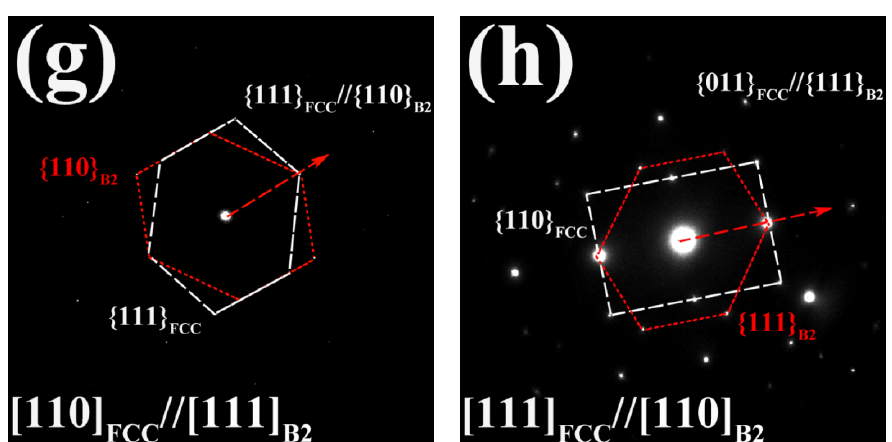
Figure 5. TEM images and corresponding SADP of B2 phase in 90% rolled and annealed samples: ( a ) AR500 sample; ( b ) AR540 sample; ( c ) AR590 sample; ( d ) AR660 sample; ( e ) AR700 sample; ( f )